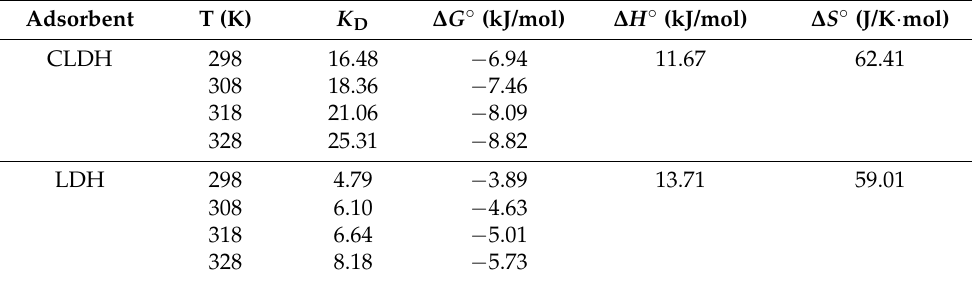
Figure 8. Effect of temperature on the adsorption of PBV by CLDH and LDH: C 0 = 15 mg/L, agitation time = 2 h, initial pH = 5.57 and R = 0.1 g/L. Table 5. Thermodynamic parameters of the adsorption of PBV by CLDH and LDH.